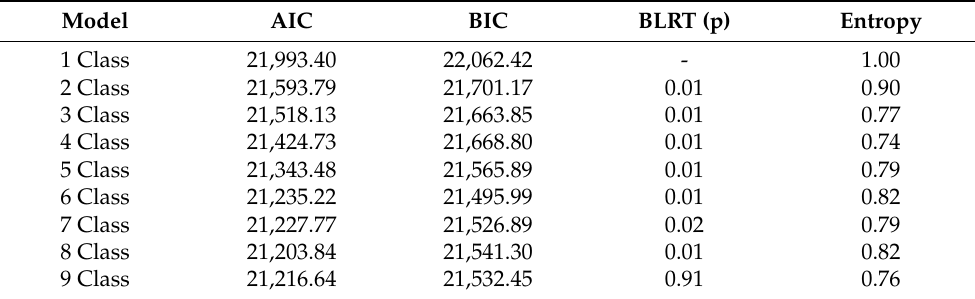
Table 1. Model parameters of latent profile analyses based on psychopathy, temperament, and personality disorder ratings.( N = 342).